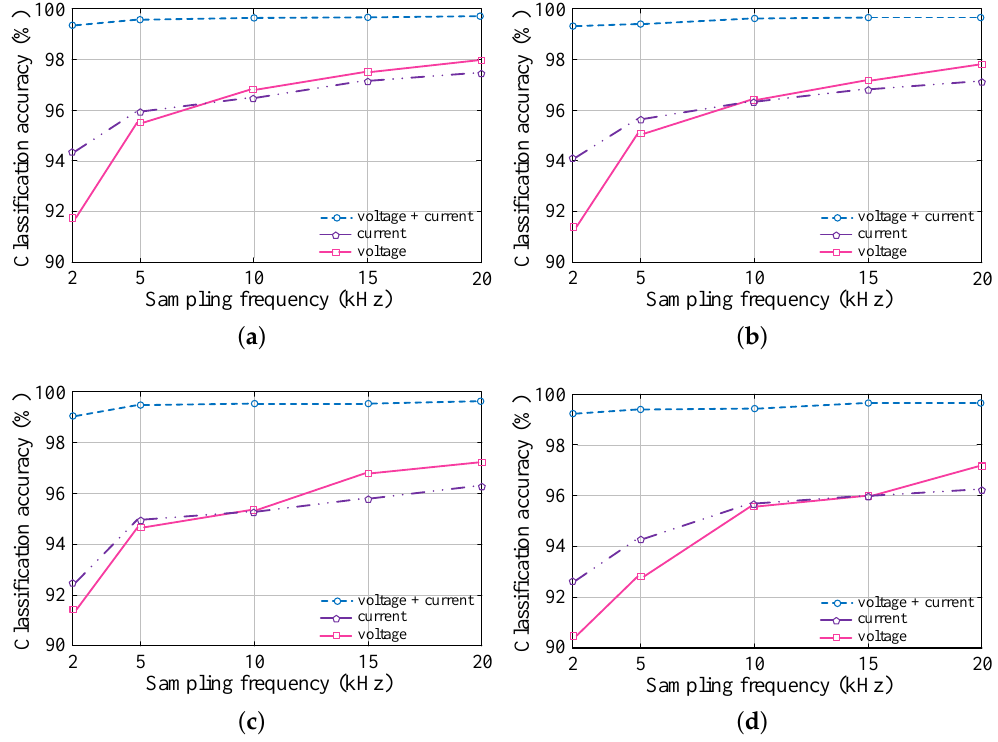
Figure 12. Classification accuracy of the proposed classifier with various sampling frequencies and types of signals for the ( a ) grid-tied radial, ( b ) grid-tied loop, ( c ) islanded radial, and ( d ) islanded loop mode operation of the considered